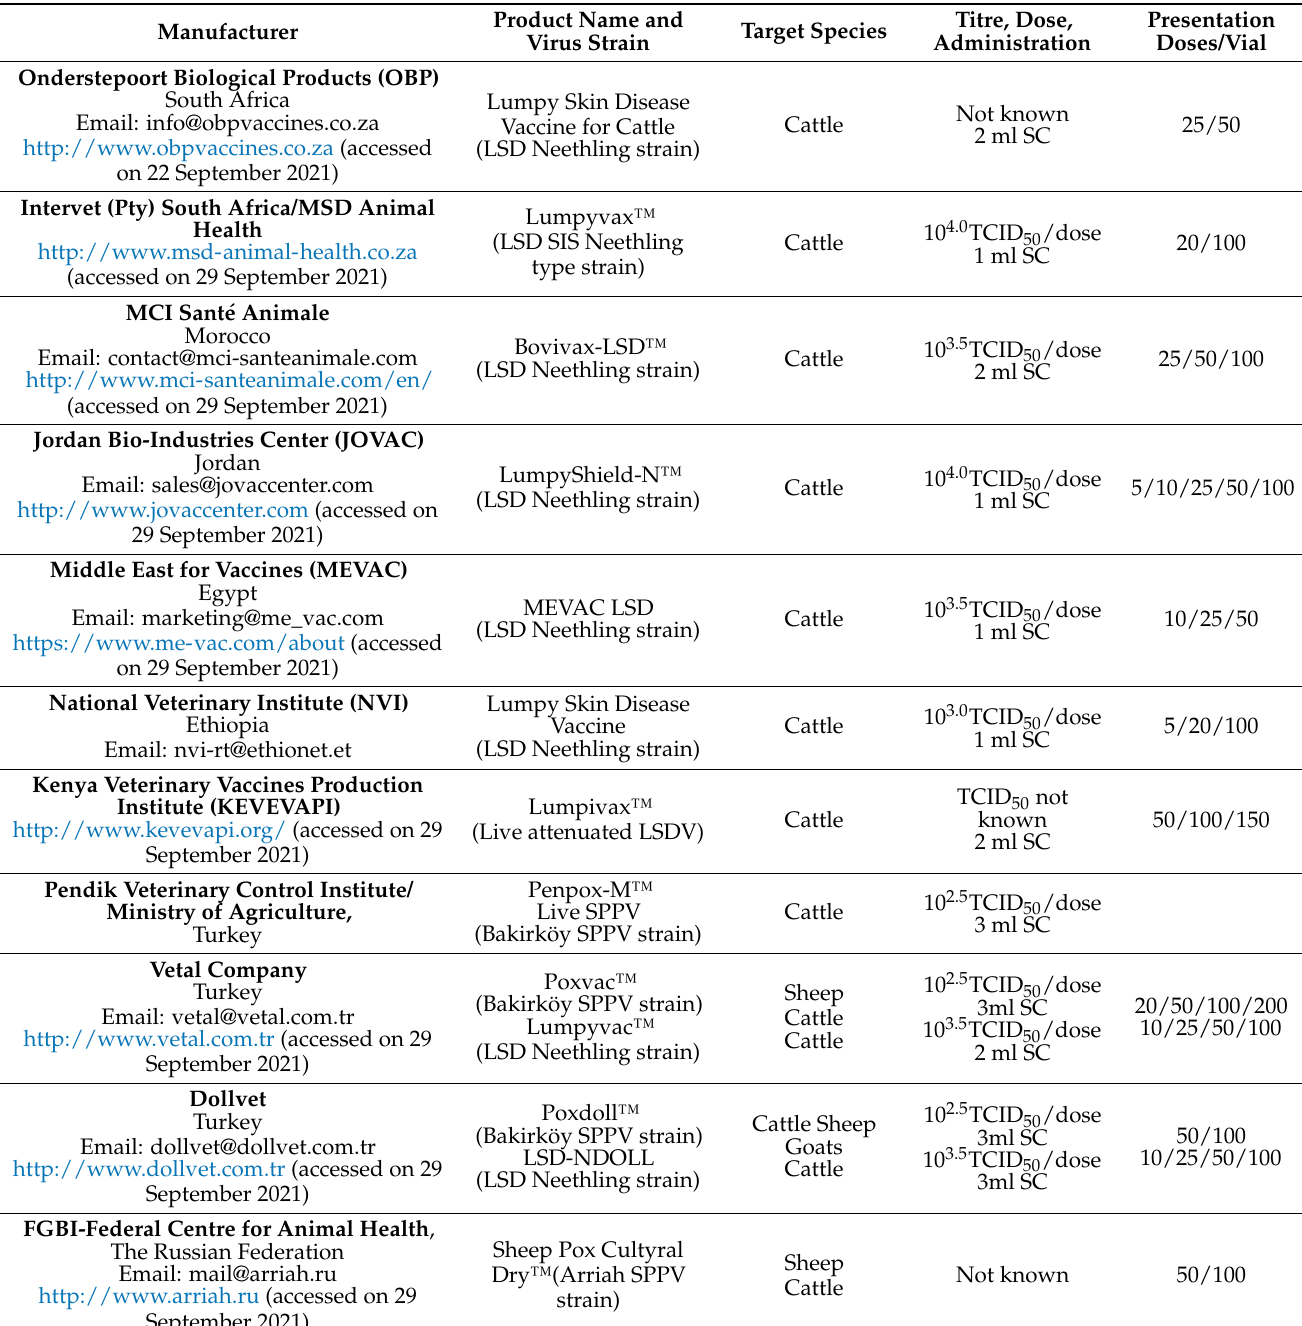
Table 1. Most commonly used vaccines registered for use in cattle against lumpy skin disease (LSD). (Links accessed on 22 September